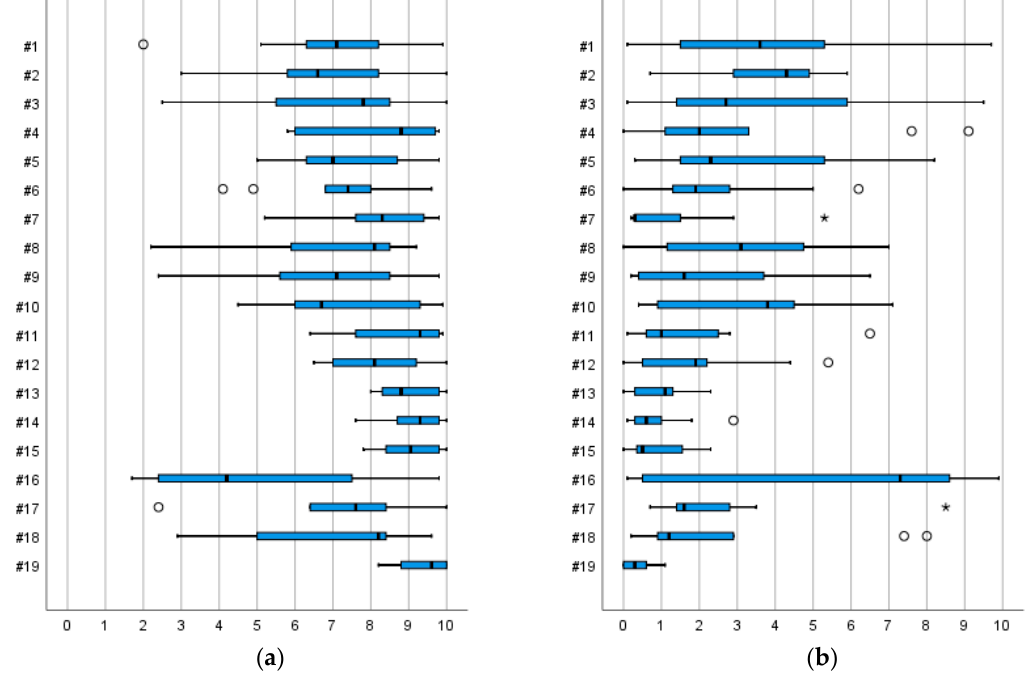
Figure 4. ( a ) Perceptions of walking balance and ( b ) of risk of falling on an uncovered ice surface, respectively, with the 19 devices. Scale 0–100. Boxplot graph shows median values and upper and lower quartiles. Whiskers indicate variability outside the quartiles and outliers are plotted as individual points.